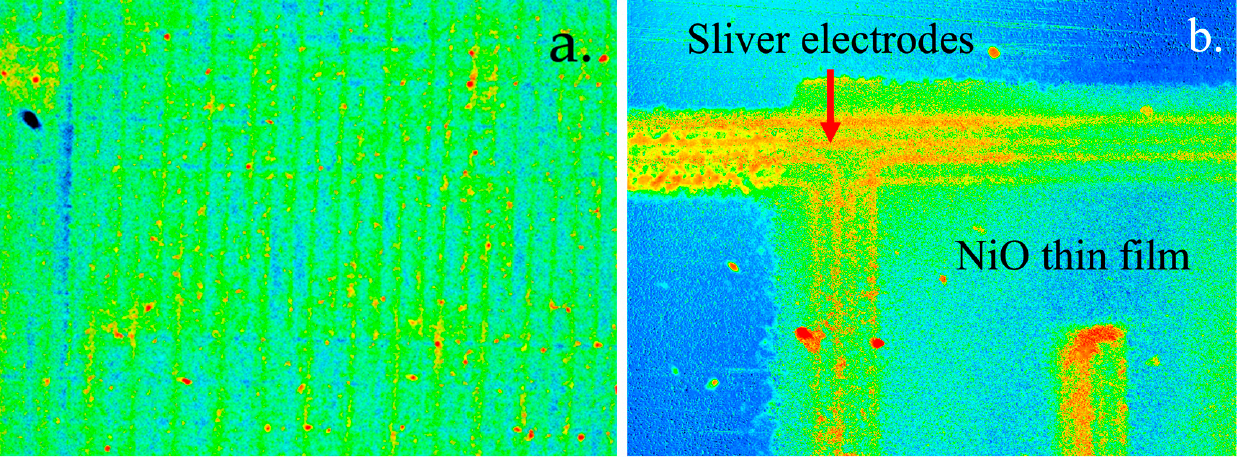
Figure 3. The colormaps of confocal microscopy to show the height difference of NiO thin film which were caused by electrodes ( a ) on ITO electrodes ( b ) on silver electrodes. Furthermore, some satellite points were found in the printed raw NiO thin films.